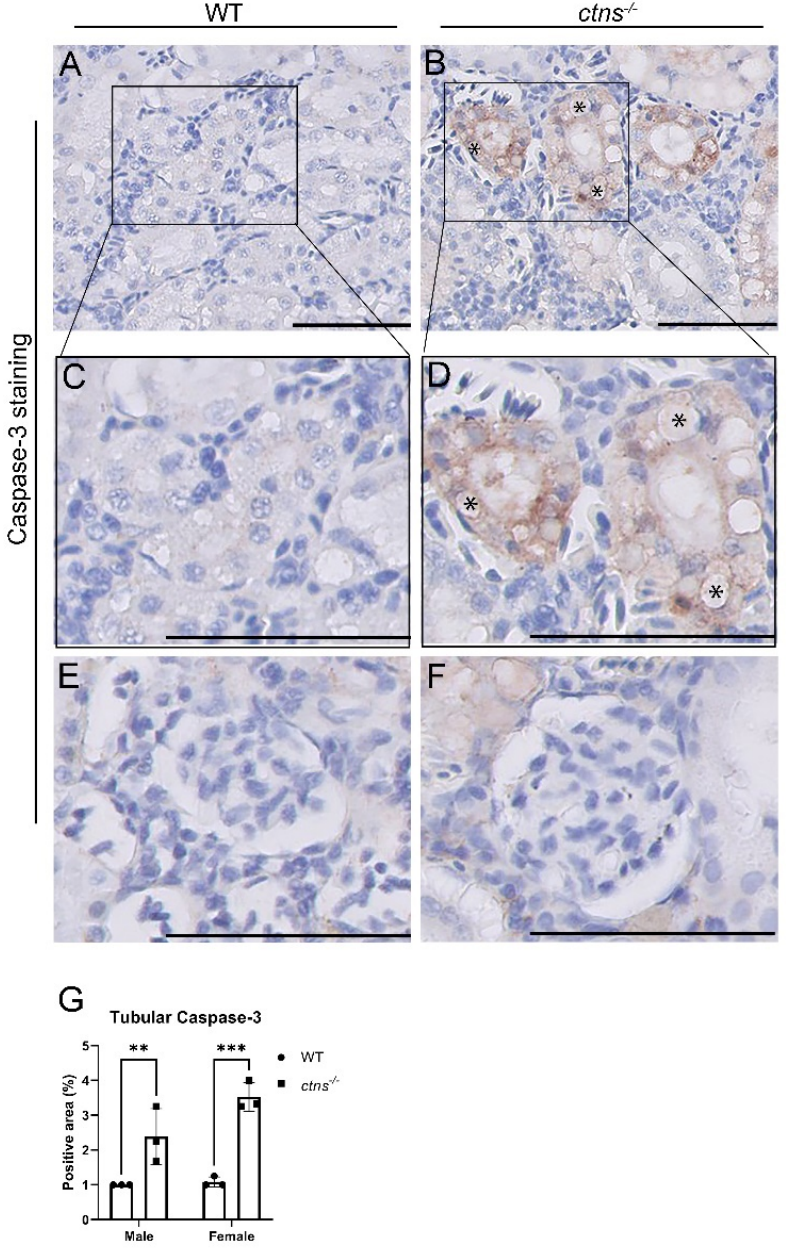
Figure 5. Increased apoptosis in PTECs with vacuoles in ctns − / − zebrafish. ( A , B ) Representative images of the cleaved caspase-3 immunostaining of tubules of wild-type ( A ) and ctns − / − ( B ) 18-month-old zebrafish. The scale bars represent 50 µ m. ( C , D ) The bottom panels show a higher magnification of the boxed areas in the upper panels. Details of PTECs with cytoplasmic vacuoles (*). The scale bars represent 50 µ m. ( E , F ) Representative images of the cleaved caspase-3 immunostaining of glomerulus of wild-type ( E ) and ctns − / − ( F ) 18-month-old zebrafish. The scale bars represent 50 µm. ( G ) The quantification of the tubular caspase-3 staining positive area in wild-type and ctns − / − zebrafish in both genders. Each dot represents one zebrafish, for a total of n = 3 wild-type and n = 3 ctns − / − 18-month-old zebrafish. Two-way ANOVA with Fisher’s least significant difference (PLSD) test: ** p < 0.01; *** p < 0.001.